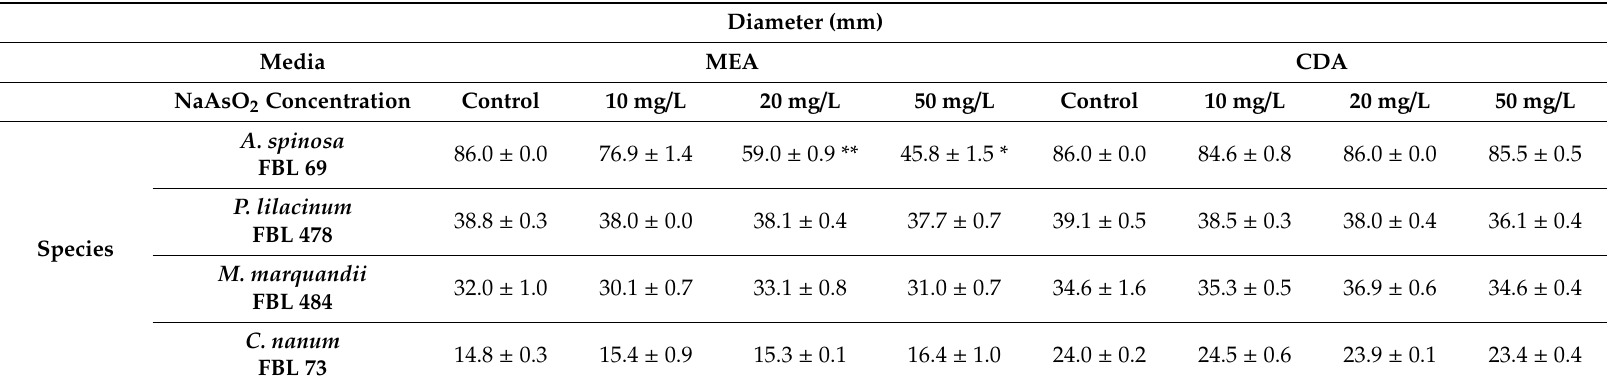
Table 1. Diametric values of fungal colonies after seven days of growth at 25 ◦ C. Data are expressed as the mean ± standard error of independent biological replicates a .